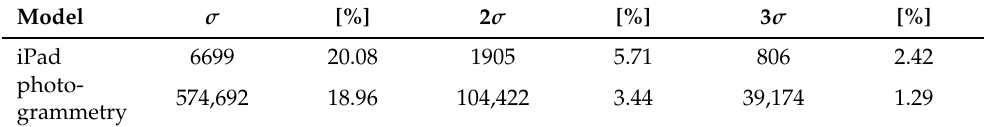
Table 8. Analysis of the number of outlying points ( σ = Q 3 = 5 [cm]) for the building